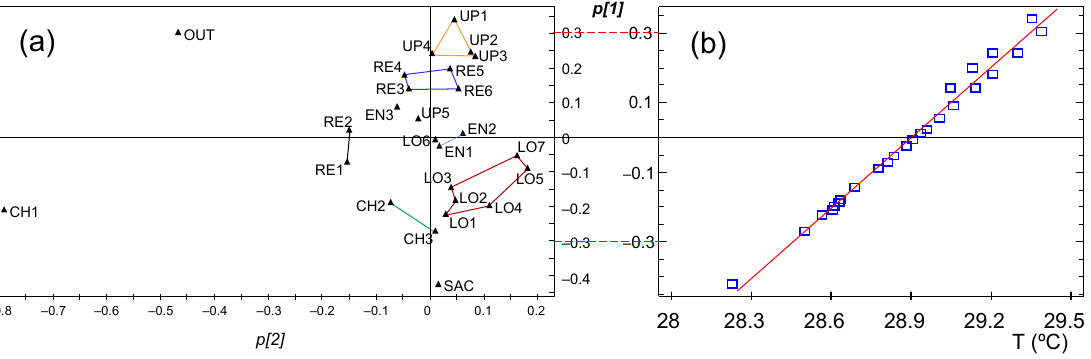
Figure 17. PCA applied to daily medians for the period of days 1–30: ( a ) loading plot for PC1 and PC2 ( p[1] vs. p[2] loadings), ( b ) scatterplot of p[1] vs. mean temperature in that period. The fitted regression line is indicated in red.